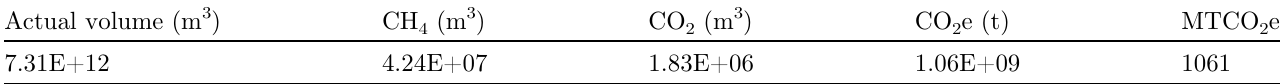
Table 4. Emission from venting during the production of shale gas from entire gas fi eld. Actual volume (m 3 )